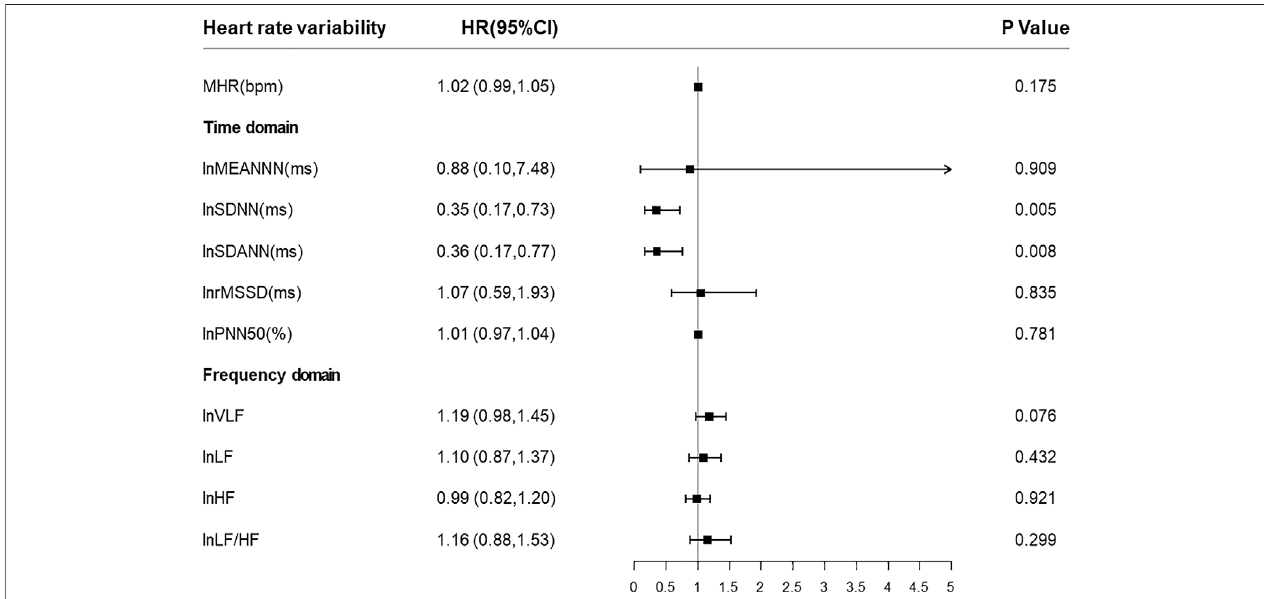
FIGURE2| ForestplotsofassociationsbetweenHRVparametersandall-causemortality.Presenttheestimateswithahorizontallinerepresenting95%con fi dence intervals (CIs). Abbreviations: HRV, heart rate variability; SDNN, SD of normal-to-normal R-R intervals; SDANN, SD of 5-minute average of normal R-R intervals.